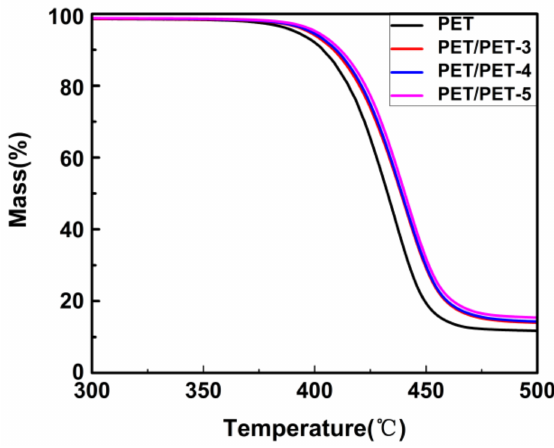
Figure 5. TGA curves of pure PET, PET/PET-3, PET/PET-4 and